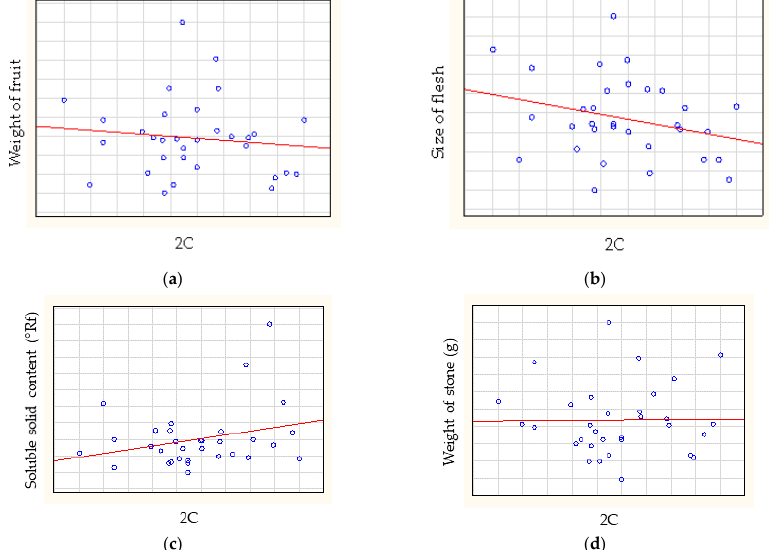
Figure 4 . The correlations between relative genome size and ( a ) weight of fruit, ( b ) size of flesh, ( c ) soluble solid content and ( d ) weight of stone.